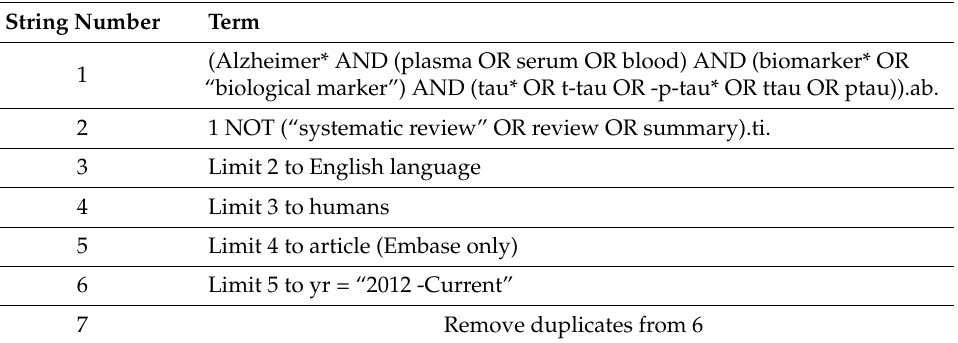
Table 1. Keywords used to search for relevant results. *: wildcard operator; ab: terms found in abstract or title; ti: terms found in title; af: terms found in all fields; yr: year of